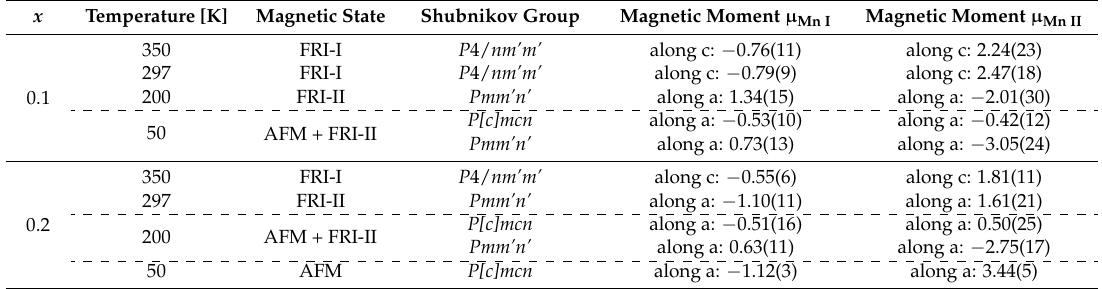
Table 3. Refined magnetic moments µ Mn1/Co1 and µ Mn2 for the different